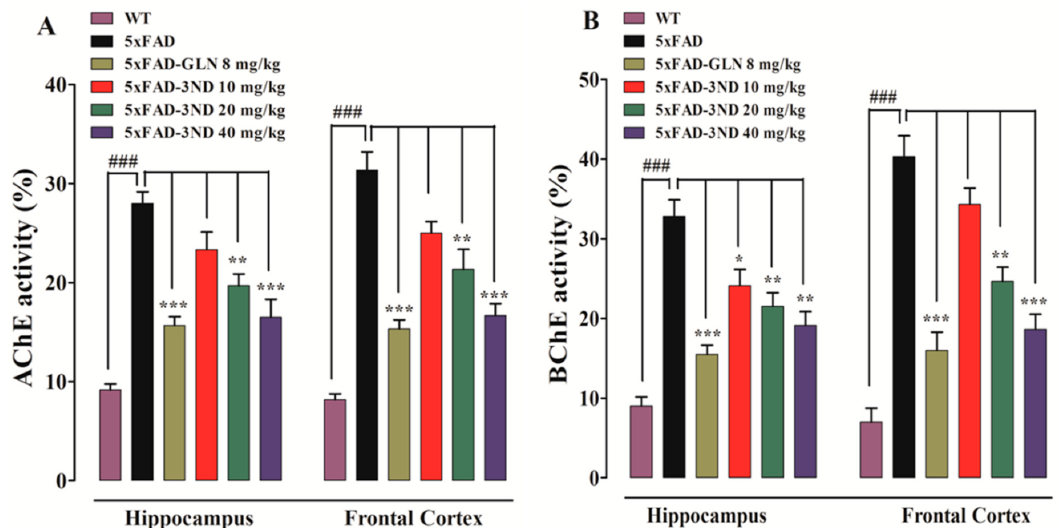
Figure 5. The effect of 3NCP on AChE level in HC and FC ( A ), the effect of 3NCP on the BChE level in both regions of brain ( B ). Data represent mean ± SEM. * p < 0.05, ** p < 0.01, *** p < 0.001 compared to 5xFAD mice, ### p < 0.001 compared to non-transgenic WT-mice, one-way ANOVA followed by Tukey’s post hoc test ( n = 4).